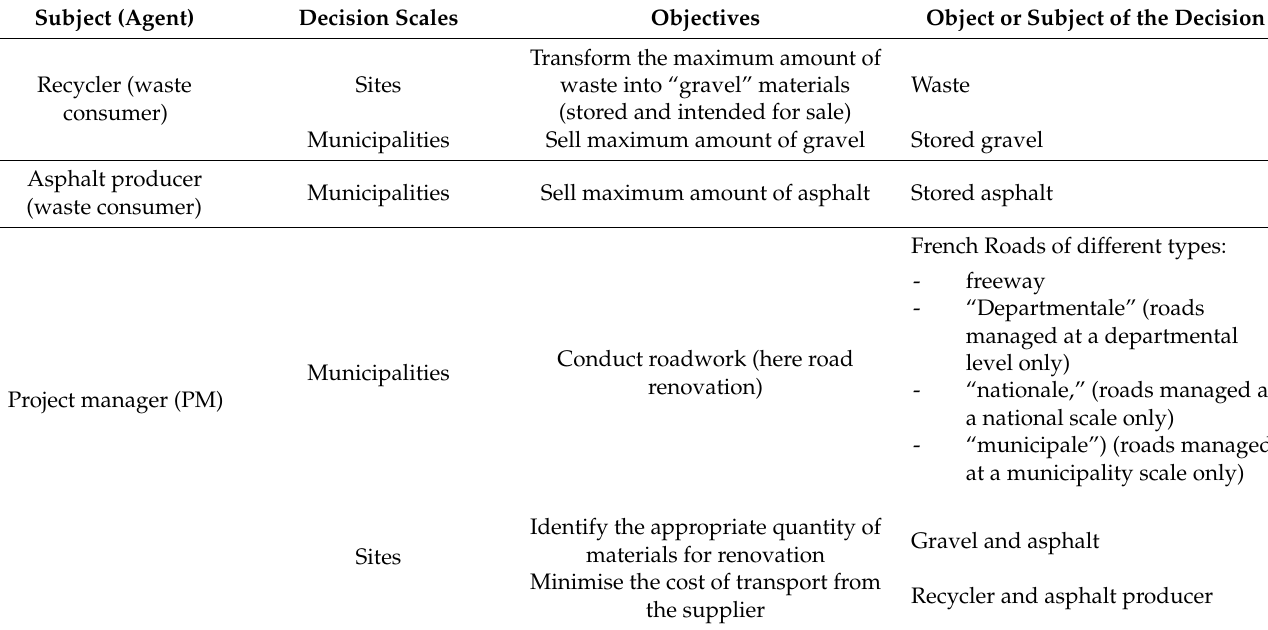
Table 3. List of decision-making entities and their respective